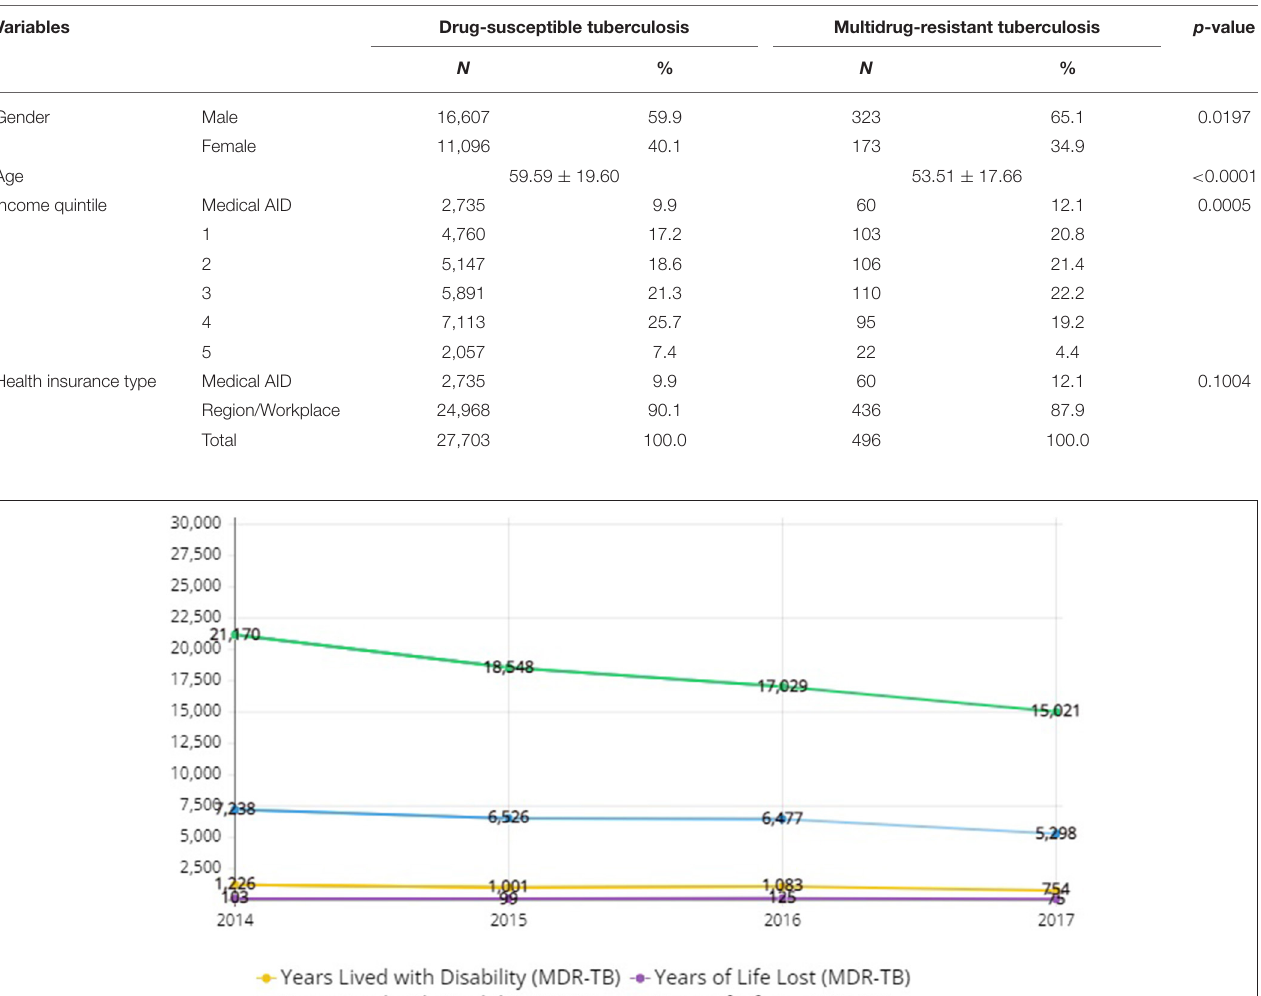
TABLE 2 | Characteristics of drug-susceptible tuberculosis and multidrug-resistant tuberculosis patient, 2017. Variables